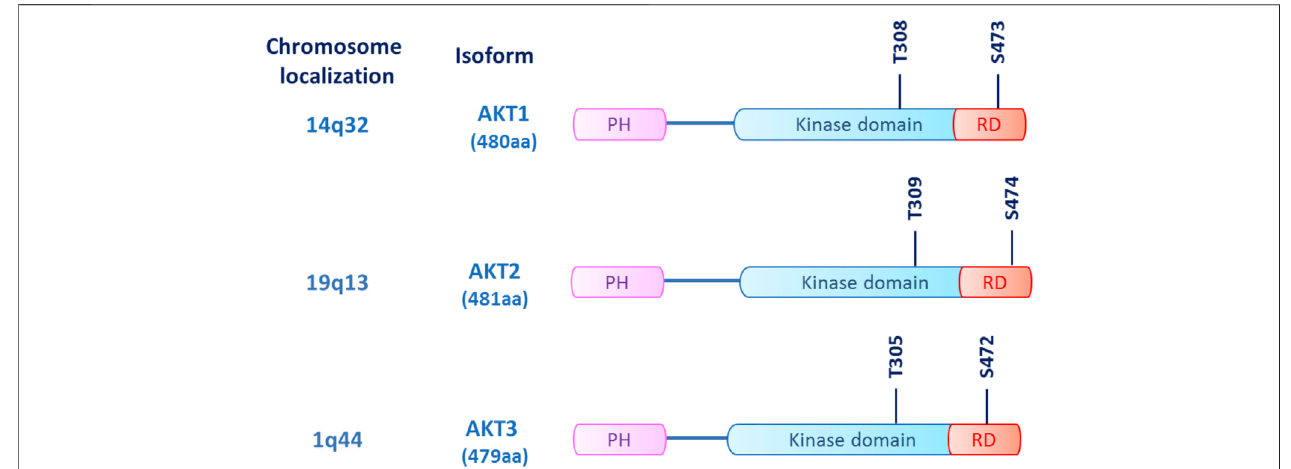
FIGURE1| AKTstructure.ThethreeAKTisoforms(AKT1/2/3)arekinasessharingacommonstructure,whichconsistsofanN-terminuspleckstrinhomology(PH) domain, a large central kinase domain and a C-terminus regulatory domain (RD). The main phosphorylation sites of AKT are threonine and serine residues located in the kinase domain (T305/T308/T309) and in the regulatory domain (S472/473/474),